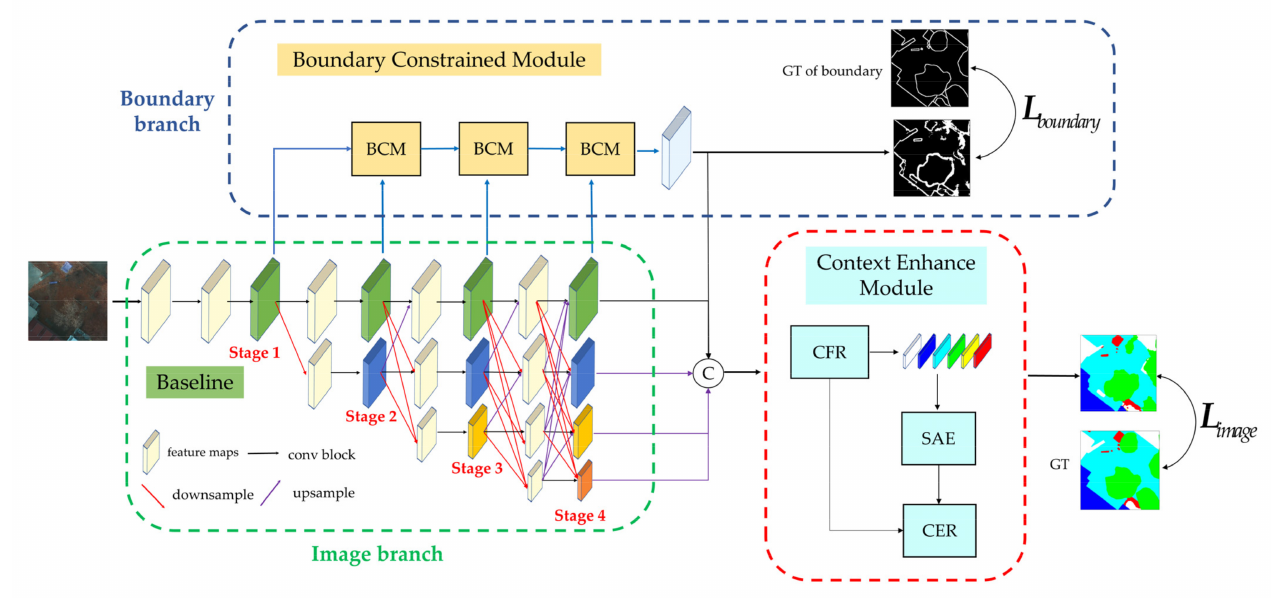
Figure 1. The overall structure of our